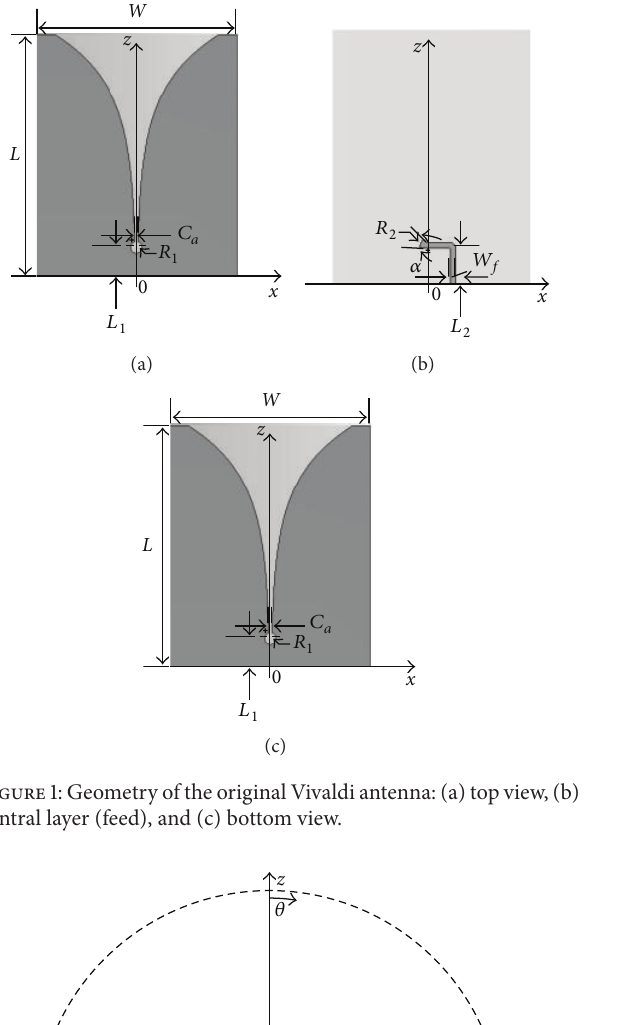
Figure 4: Normalized radiation signal waveform in E-plane ( 𝜑 = 0 ∘ ).